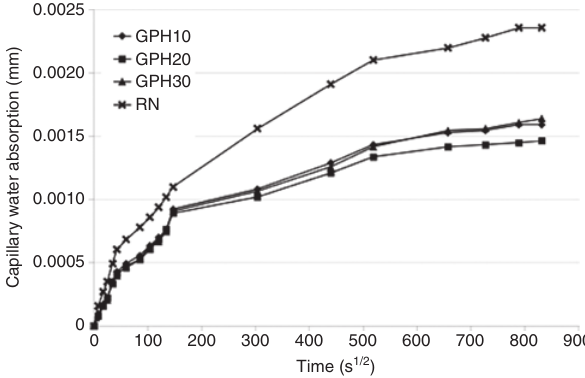
Figure 16 Capillary water absorption of polyvinyl chloride granule containing high strength concretes.